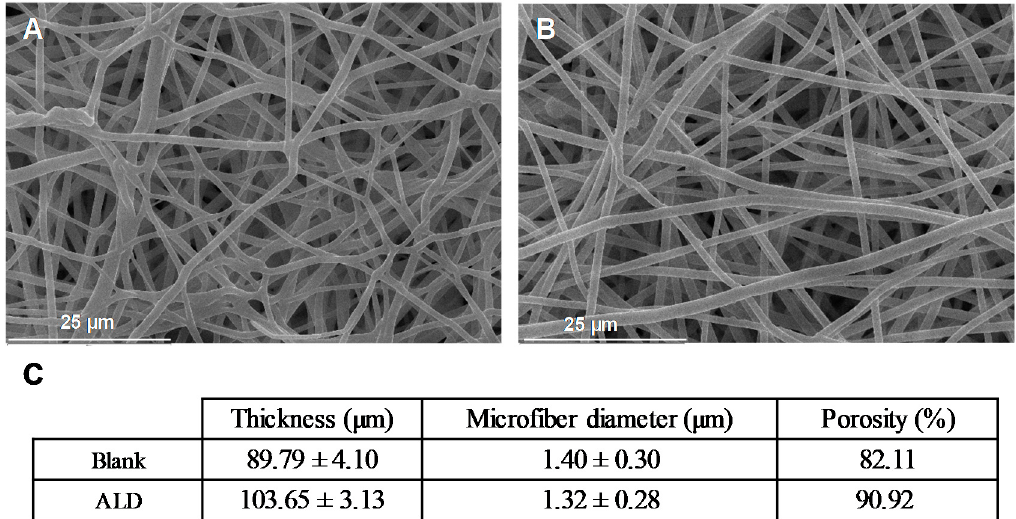
Figure 2. Scanning electron microscopy images at 1500× magnification of: ( A ) blank meshes (without ALD) and ( B ) alendronate meshes both treated with plasma oxygen. ( C ) Thickness, microfiber diameter, and porosity of the blank and ALD linked meshes.